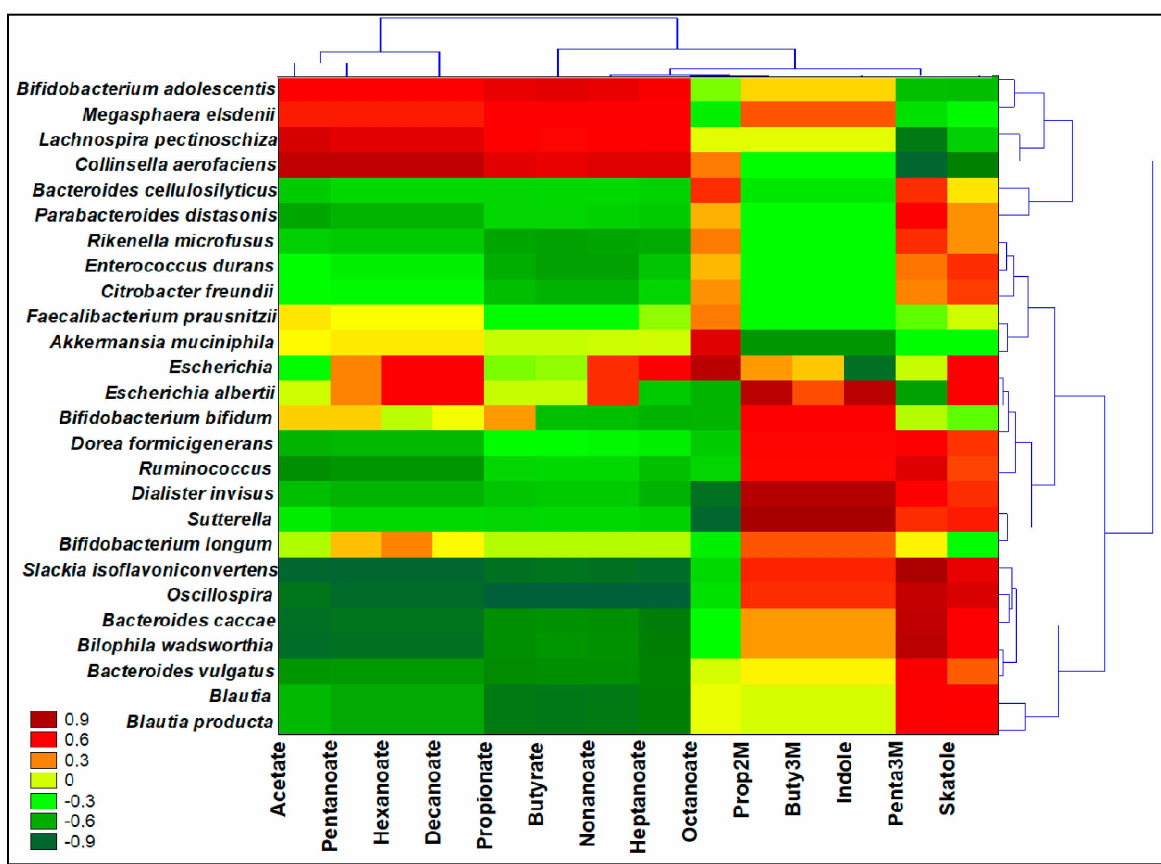
Figure 4. Interomics, Spearman Rank Correlations among main microbial metabolites from the volatilome and ANOVA significant ( p < 0.05) species OTUs from the microbiota. Prop2M = Propanoic acid, 2-metyl; Buty3M = Butanoic acid, 3-methyl; Penta3M = Pentanoic acid, 3-methyl. Left-side dendrogram identifies by Pearson analysis three major different clusters among bacterial species. Significance of correlations are provided as supplementary material (Figure